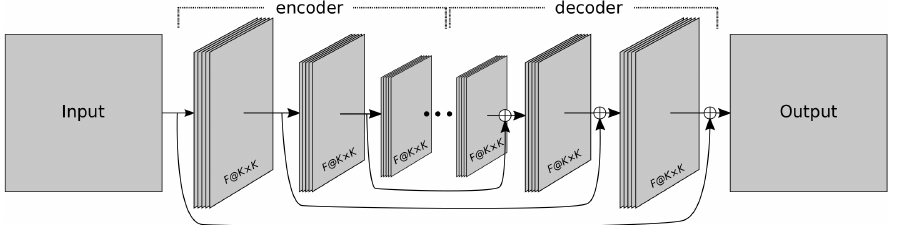
Figure 1. Example of a RED-Net topology. The number of layers can change according to the chosen topology. The symbol denotes element-wise sum of feature maps. F represents the number of ⊕ selected filters and ( K K ) the size of the ×